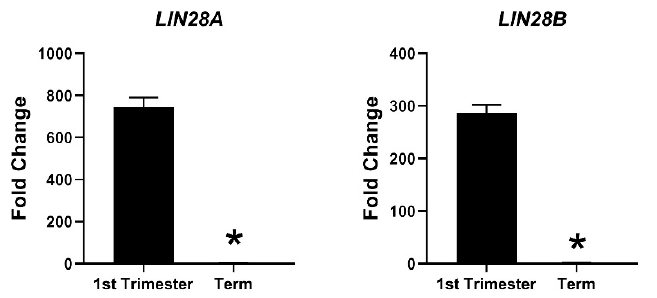
Figure 3. mRNA was extracted from first trimester (week 11) and term human placentas and LIN28A and LIN28B mRNA levels were measured using real-time RT-PCR, where * p < 0.05.